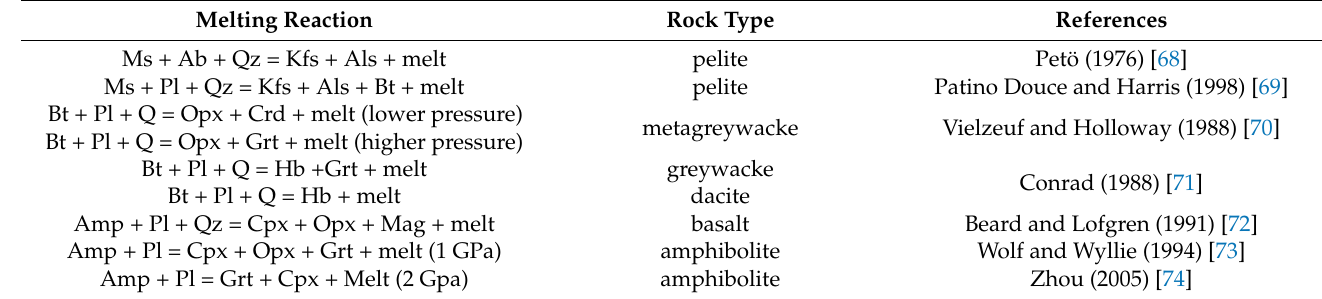
Table 1. Possible dehydration melting reactions of the crustal rock. Melting